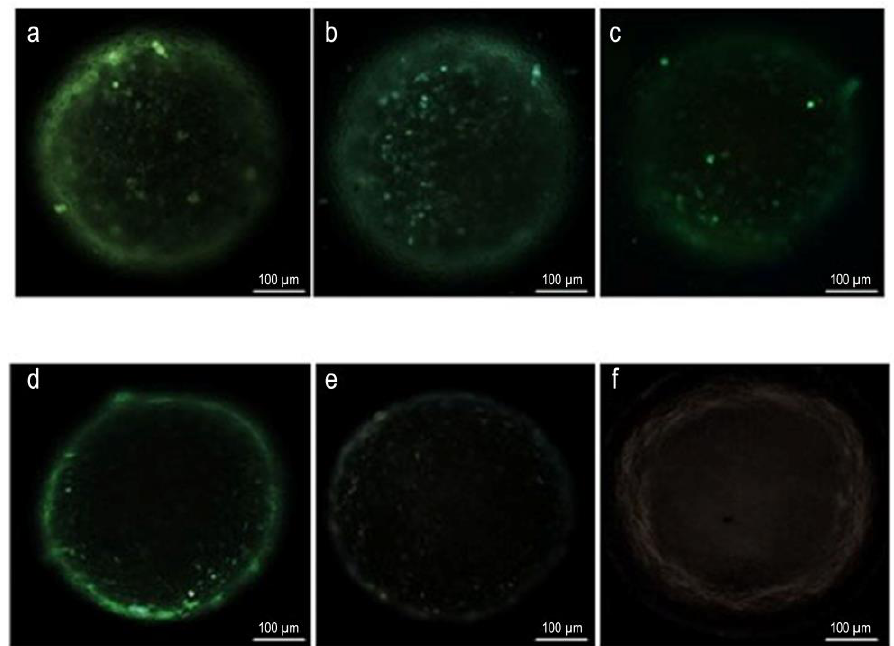
Figure 4. Determination of apoptosis in 3D CT26 spheroids incubated with 5FU/IL2/CD1 nanoplex